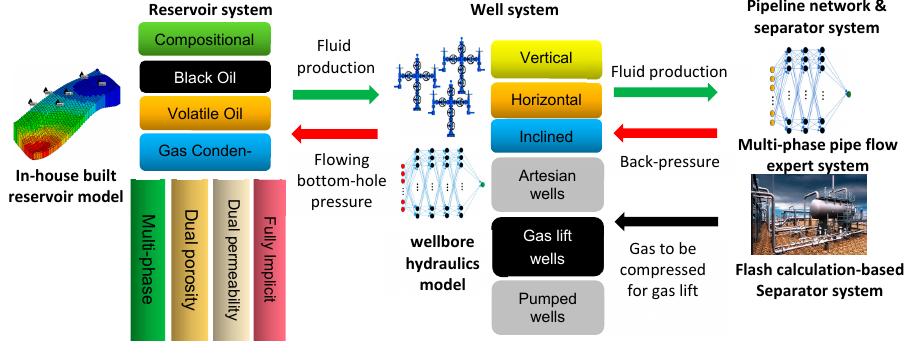
Figure 18. A fully integrated “reservoir—wellbore—surface” hybrid model.